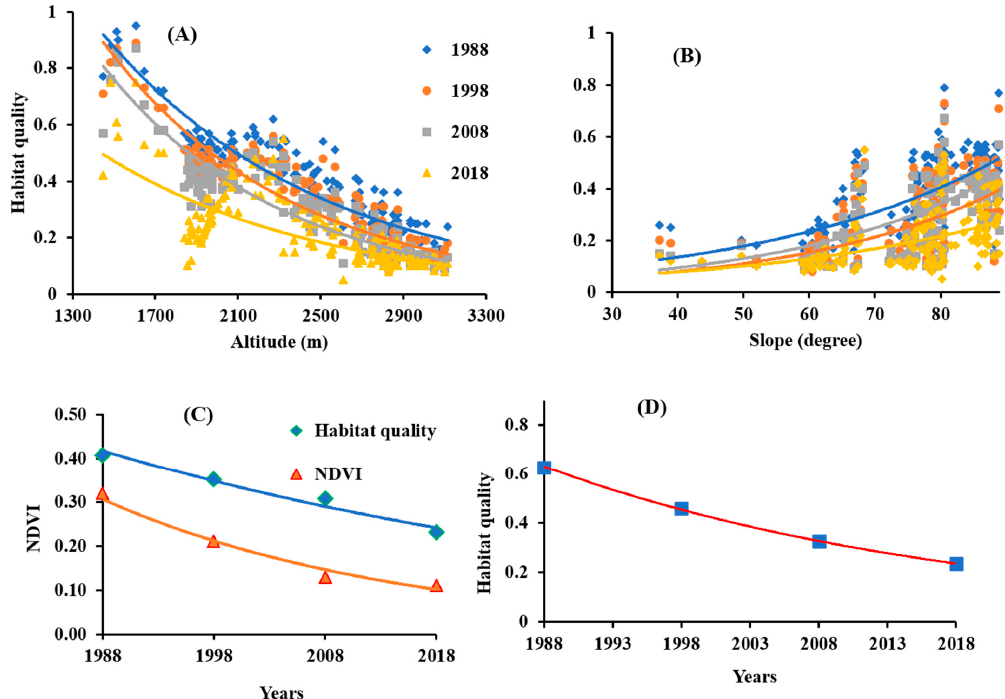
Figure 10. ( A ) and ( B ) Habitat quality status vs. altitude and slope, respectively, ( C ) Habitat quality and normalized difference vegetation index (NDVI) in relation to years and ( D ) Habitat quality status in relation to years.